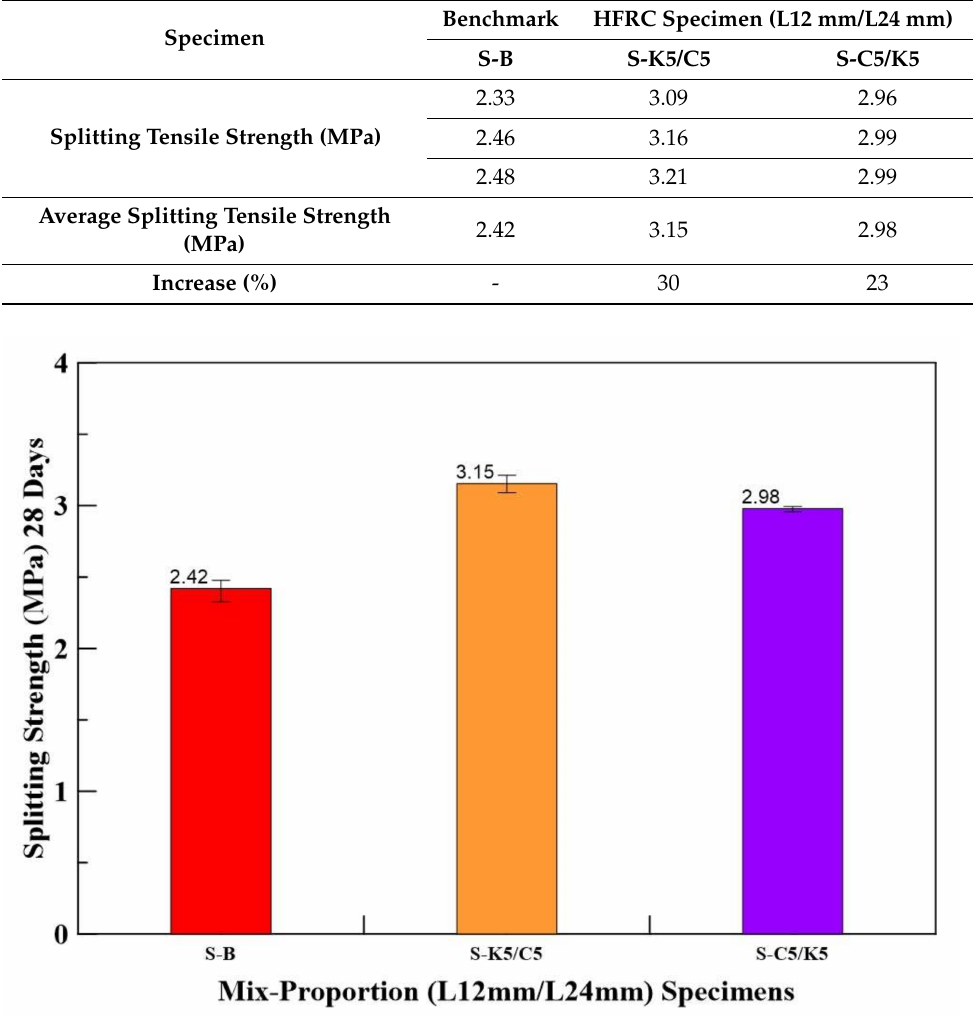
Figure 10. Bar chart for average splitting tensile strengths of benchmark and HFRC